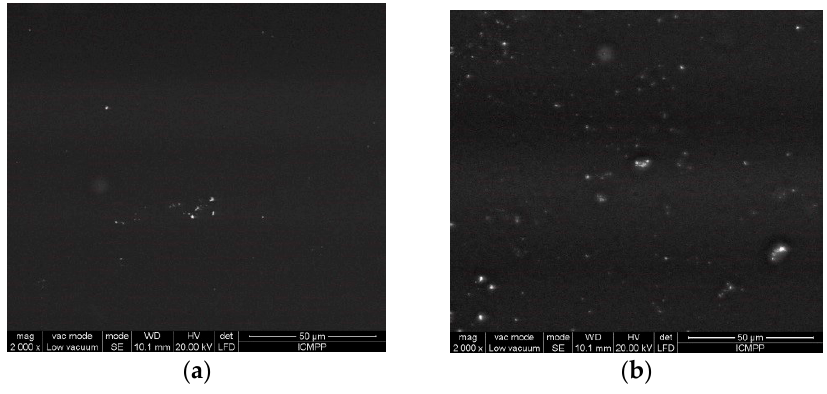
Figure 12. SEM images of ( a ) CS and ( b ) CS/rosemary or clove oil/T80 films at a 2000× magnification